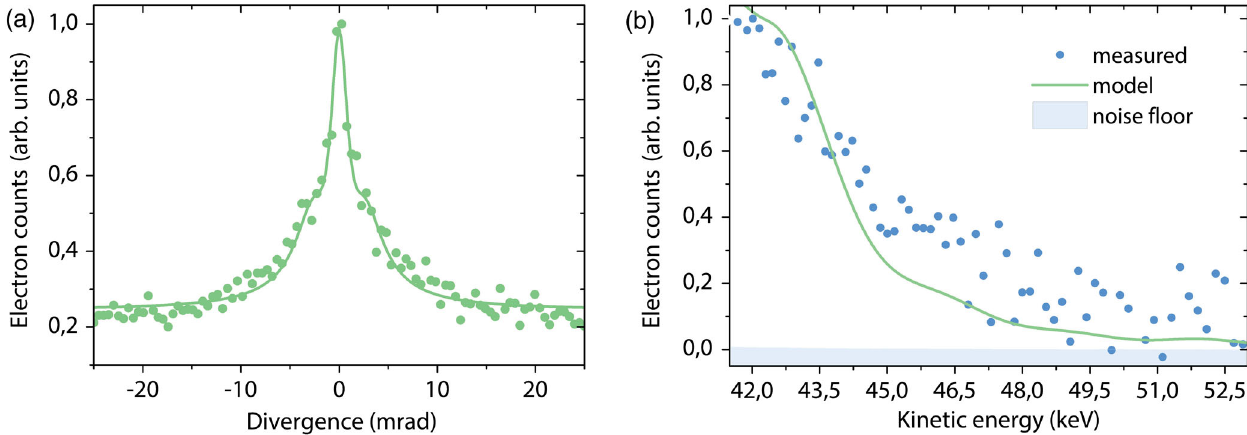
FIG. 4. Electron bunch after interaction. (a) Modeled histogram of electrons with final electron kinetic energy ranging from 42 to 53 keV as a function of divergence with half-angle deflection of less than 25 mrad. From model, FWHM divergence of the electron bunch is expected to be 3.28 mrad. (b) Final measured and modeled kinetic energy of accelerated electron in the region of interest up to 53